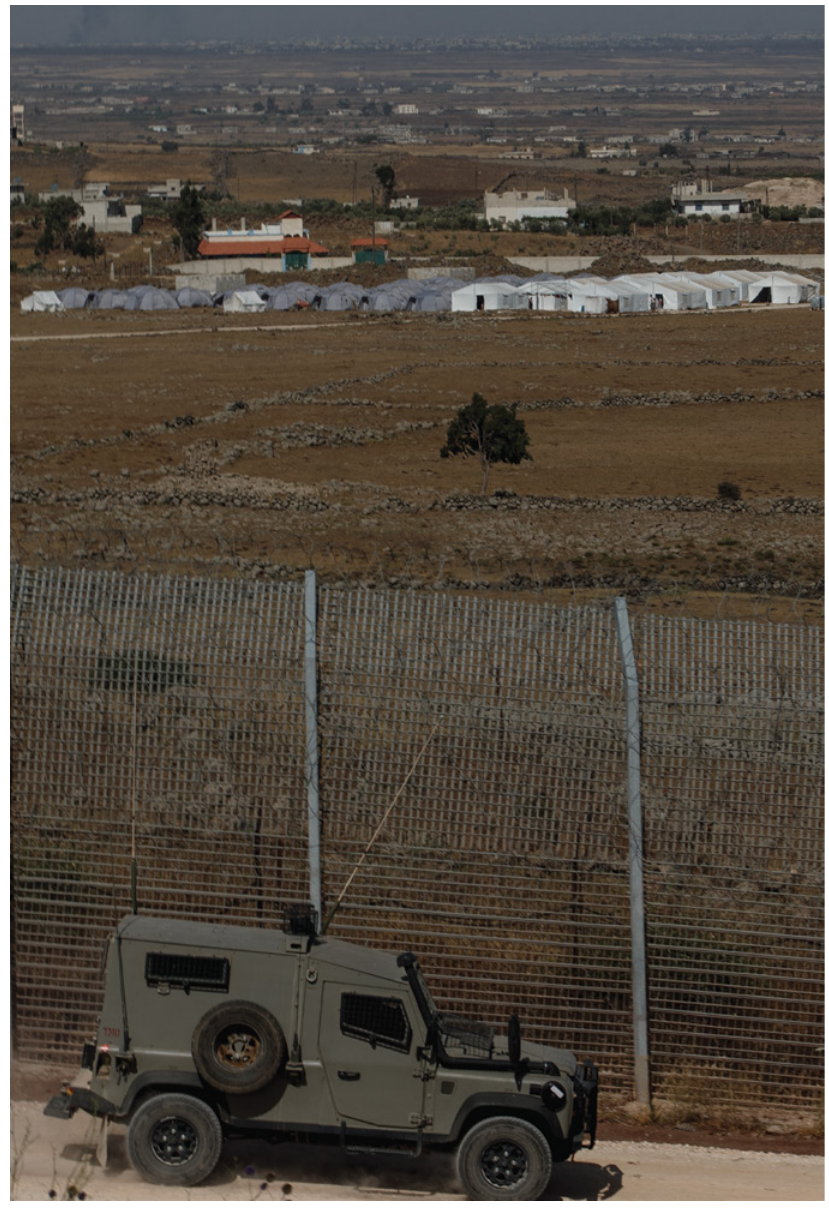
Figure 3. An Israeli army vehicle patrols the Israeli-Syrian border, near a refugee camp on the Syrian side of the border in the Golan Heights near the Syrian village of Aesheh, June 27, 2014. Photo by Ancho Gosh and Gil Eliyahu –